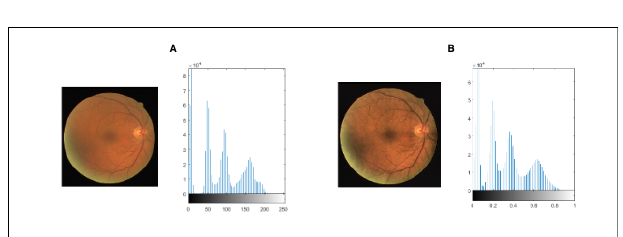
Figure 3. Contrast Limited Adaptive Histogram Equalization enhances contrast; (A) before and (B) after CLAHE application.